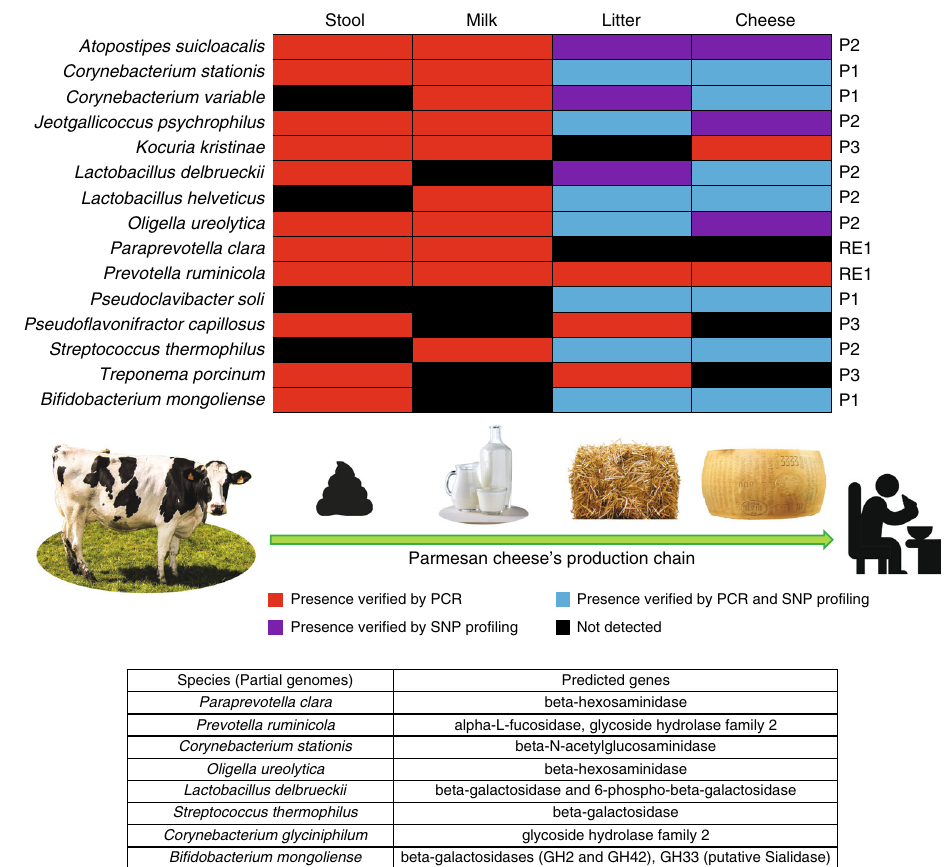
Fig. 4 Strain-speci fi c tracing of bacterial transmission events. The heat map reports in red, purple, and blue the successful strain-speci fi c identi fi cation of genomes assembled from shotgun metagenomics data by means of PCR, SNP pro fi ling or PCR and SNP pro fi ling, respectively. Presence of these strains was tested in the CF, LIT, MIL, and PC matrices sampled from the same cheese production site where they were identi fi ed. The production site is reported on the right side of the heat map. The table reports genes involved in utilization of milk-related carbohydrates predicted in the partial genomes of the traced strains. Source data are provided as a Source Data fi